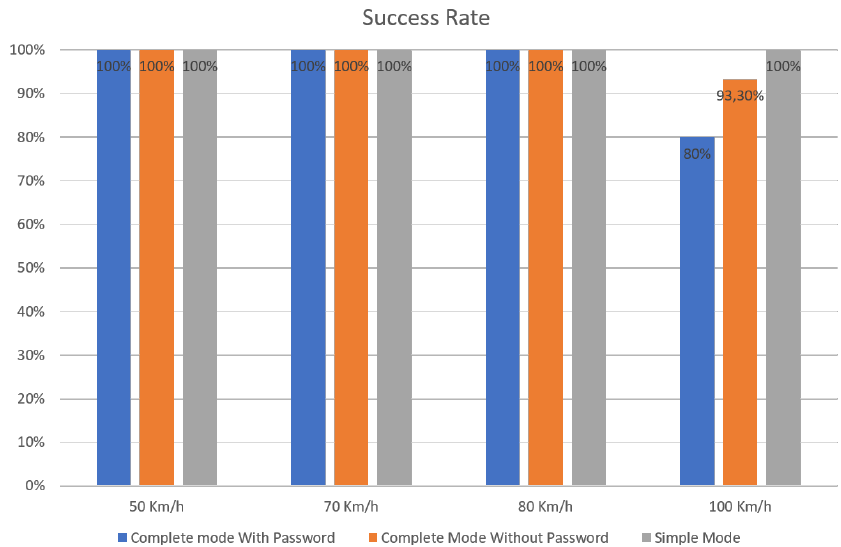
Figure 17. Test results of NOVA-WiFi-Beacons (NWBs) interacting with NWCs moving at different speeds.